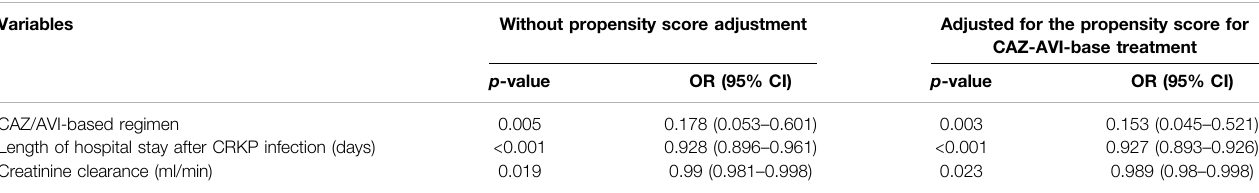
TABLE 6 | Cox regression analysis of risk factors for patients with CRKP infection for 28-day mortality. Variables Without propensity score